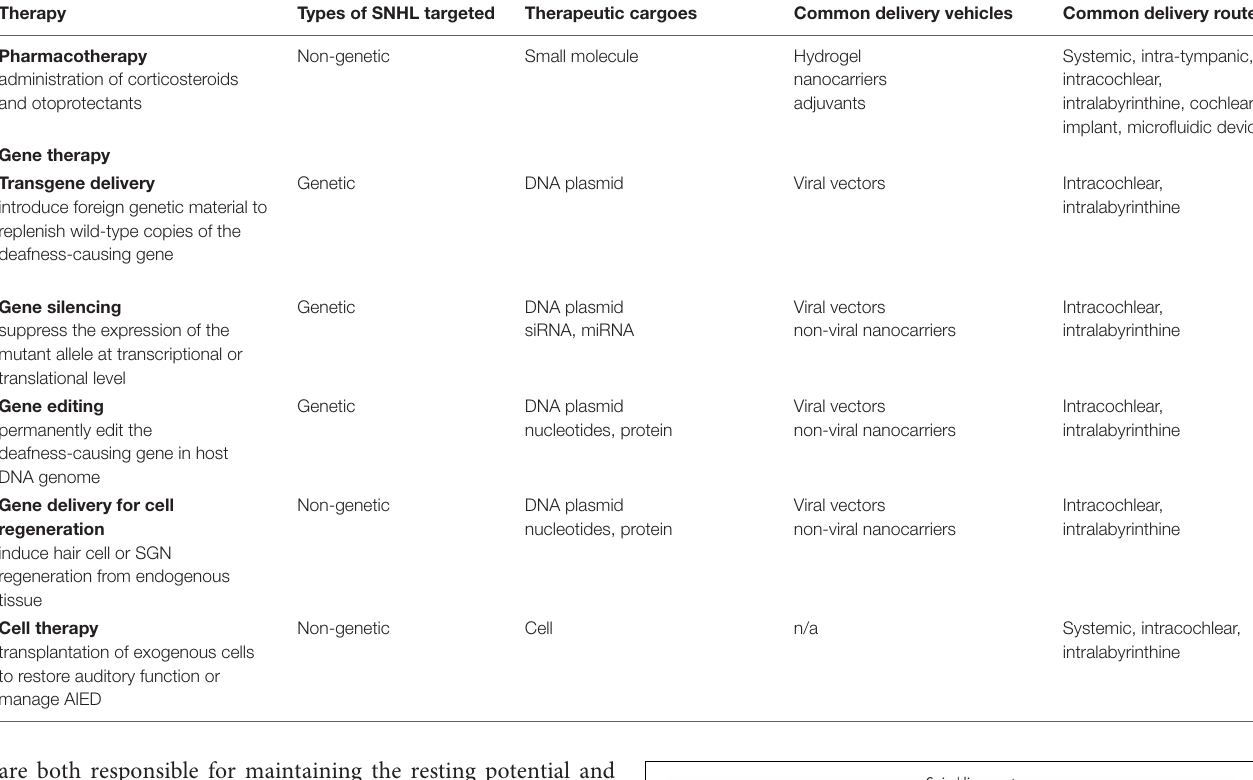
TABLE 2 | General pharmacotherapy, gene therapy, and cell therapy treatment strategies for SNHL. Therapy